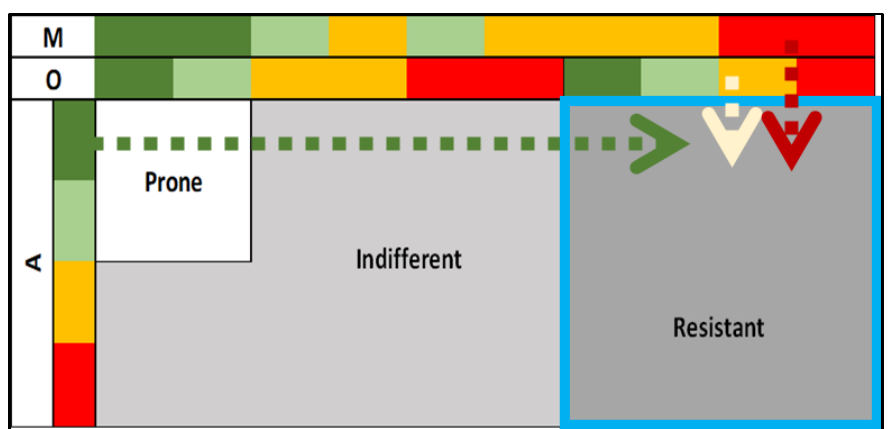
Figure 12. An Example for Identifying the Energy-Use Profile of a Hotel Guest. Following the same process, the energy-use profiles for the 370 hotel guests participated in this study were identified. The results indicated that about 45% of the hotel guests have Resistant to Change energy-use profiles, about 40% have Indifferent to Change energy-use profiles, and only 15% of the hotel guests have Prone to Change energy-use profiles. This illustrates that 45% of the hotel guests have bad or dark energy consumption behavior, 40% have moderate energy consumption behavior, and only 15% of the hotel guests have good energy consumption behavior (see Figure 13).